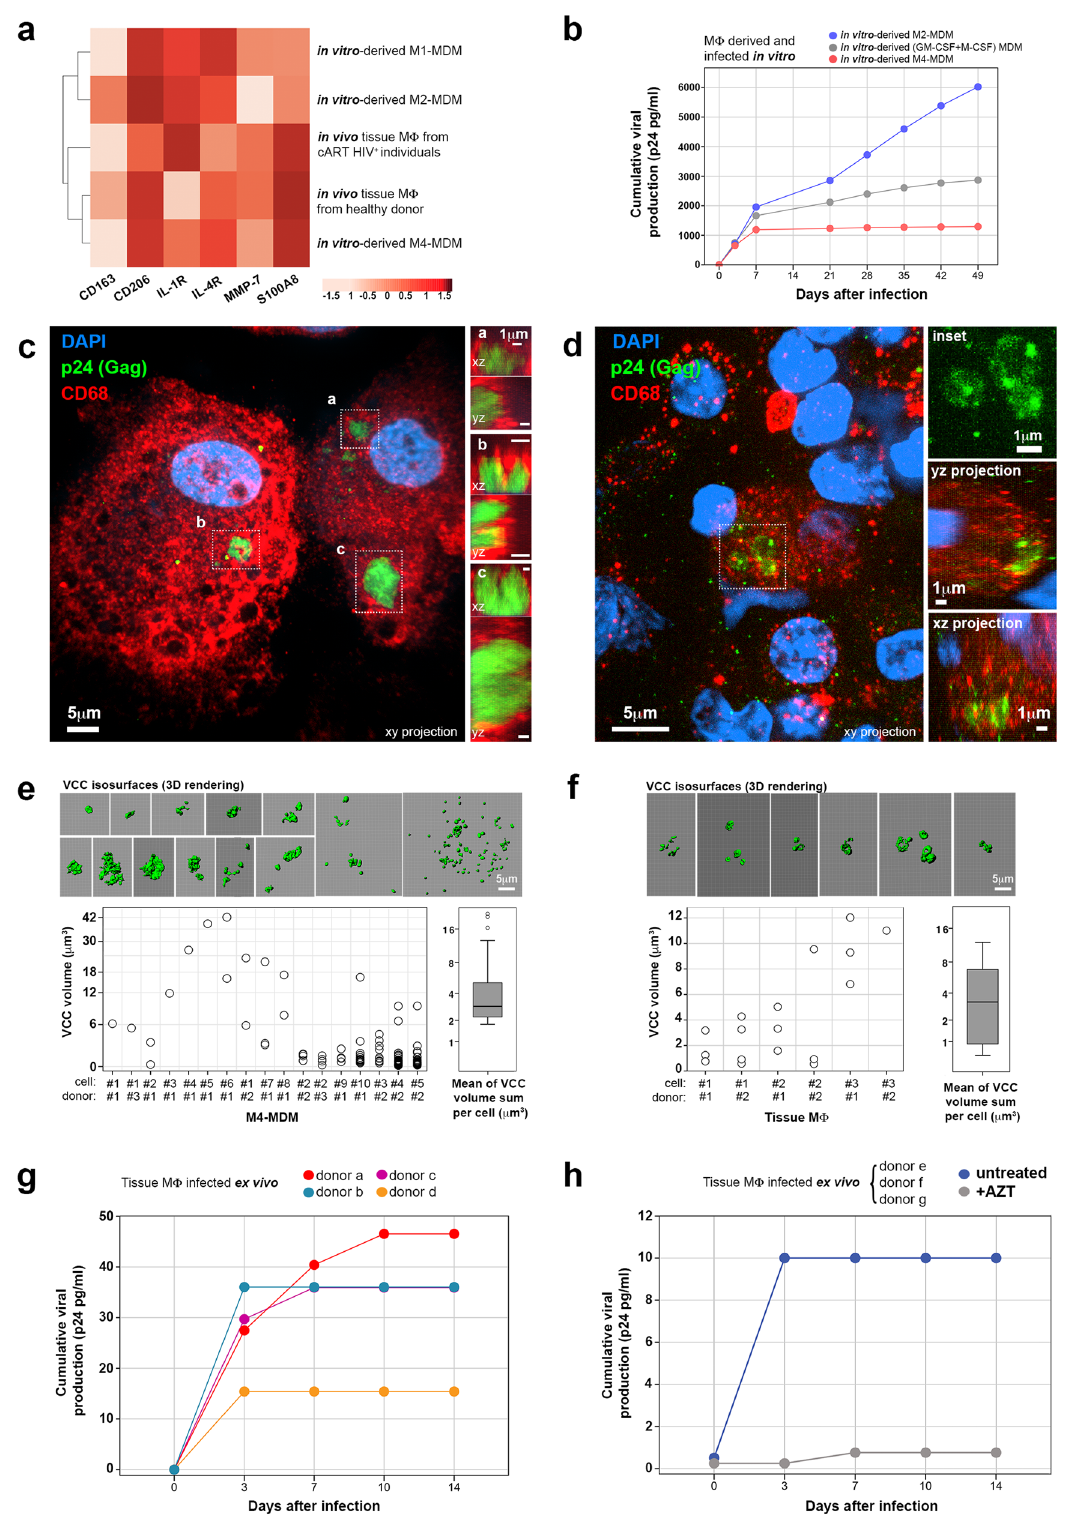
p24-Gag immunodetection in CD68 + macrophages further demon- strated thatclustersofp24 (Gag) proteins co-localized with HIV-1 RNA, a pattern suggestive of VCCs before ex vivo S100A8 treatment (Supplementary Fig. 5c, upper). Upon S100A8-mediated HIV-1 reacti- vation, both HIV-1 RNA and protein relocalized at the macrophage plasma membrane that is suggestive of extemporaneous production of new HIV-1 particles and/or mobilization of VCCs to the macrophage